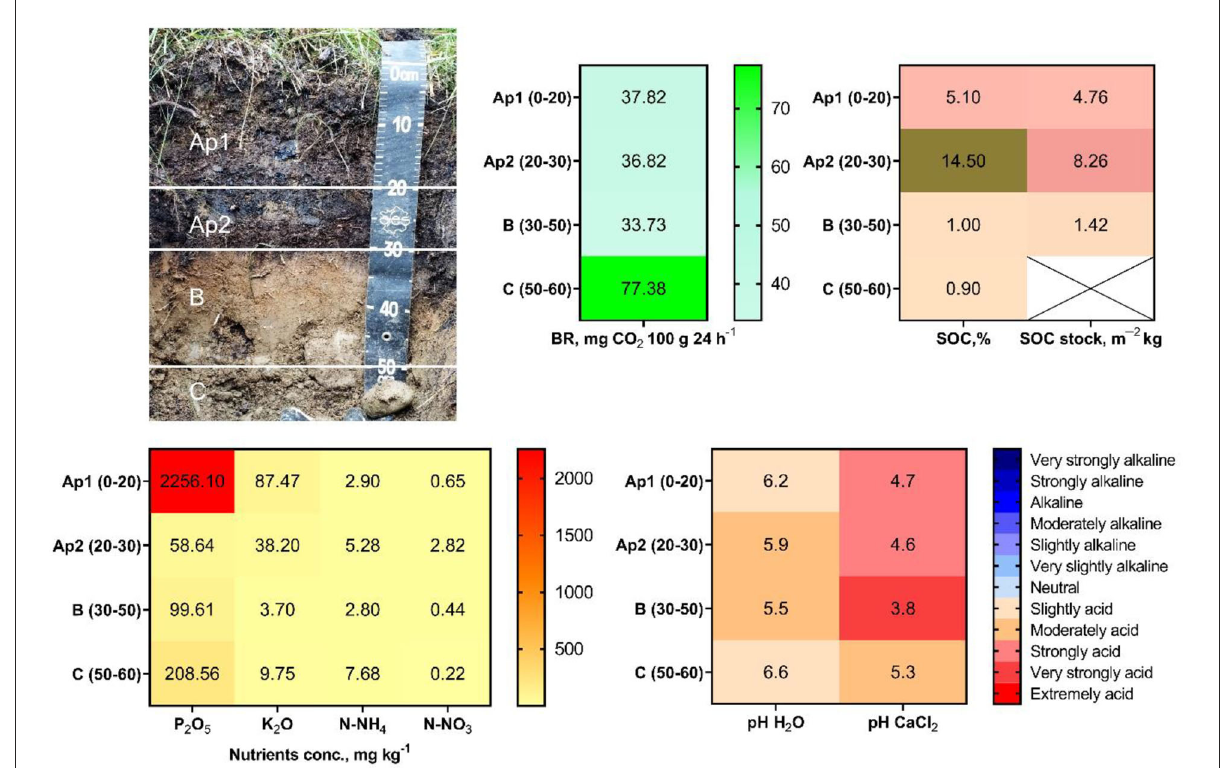
FIGURE10 Main soil properties in the second vegetable garden in Polyarny village. Soil name: Hortic Anthrosol (WRB, 2015).